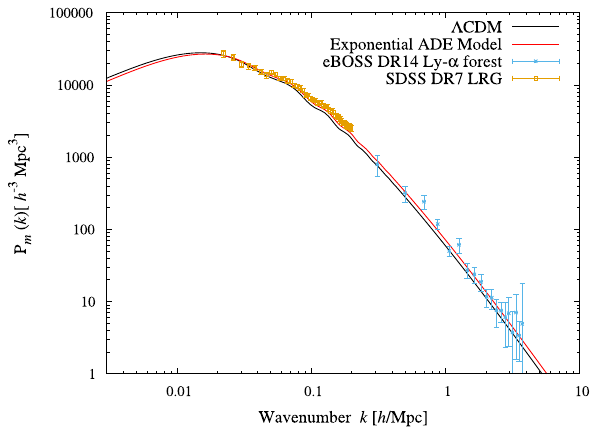
Fig. 4 Matter power spectra for the (cid:2) CDM and the eADE model with data points in different scales. The Ly- α data from eBOSS clustering on the small scales, and SDSS Luminous Red Galaxy(LRG) clustering on the intermediate scales